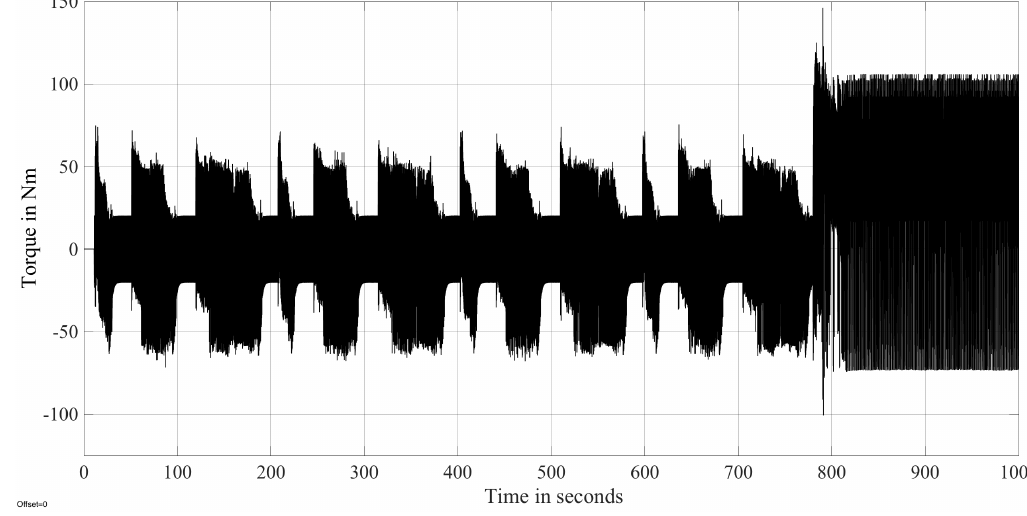
Figure 15. Motor torque with the system under a PI controller.